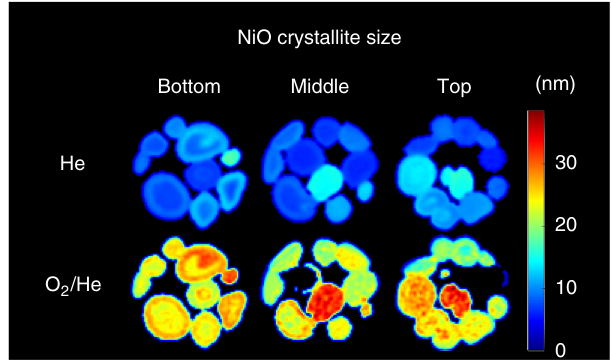
Fig. 5 NiO crystallite size evolution. Maps of crystallite sizes of NiO (units in nm) as obtained from the Rietveld analysis of the XRD-CT data collected at the bottom, middle and top of the sample (XRD-CT scans 1, 15 and 30, respectively). Top row: catalyst under He fl ow, bottom row: catalyst under 20% O 2 /He fl ow. Scale bar corresponds to 1 mm